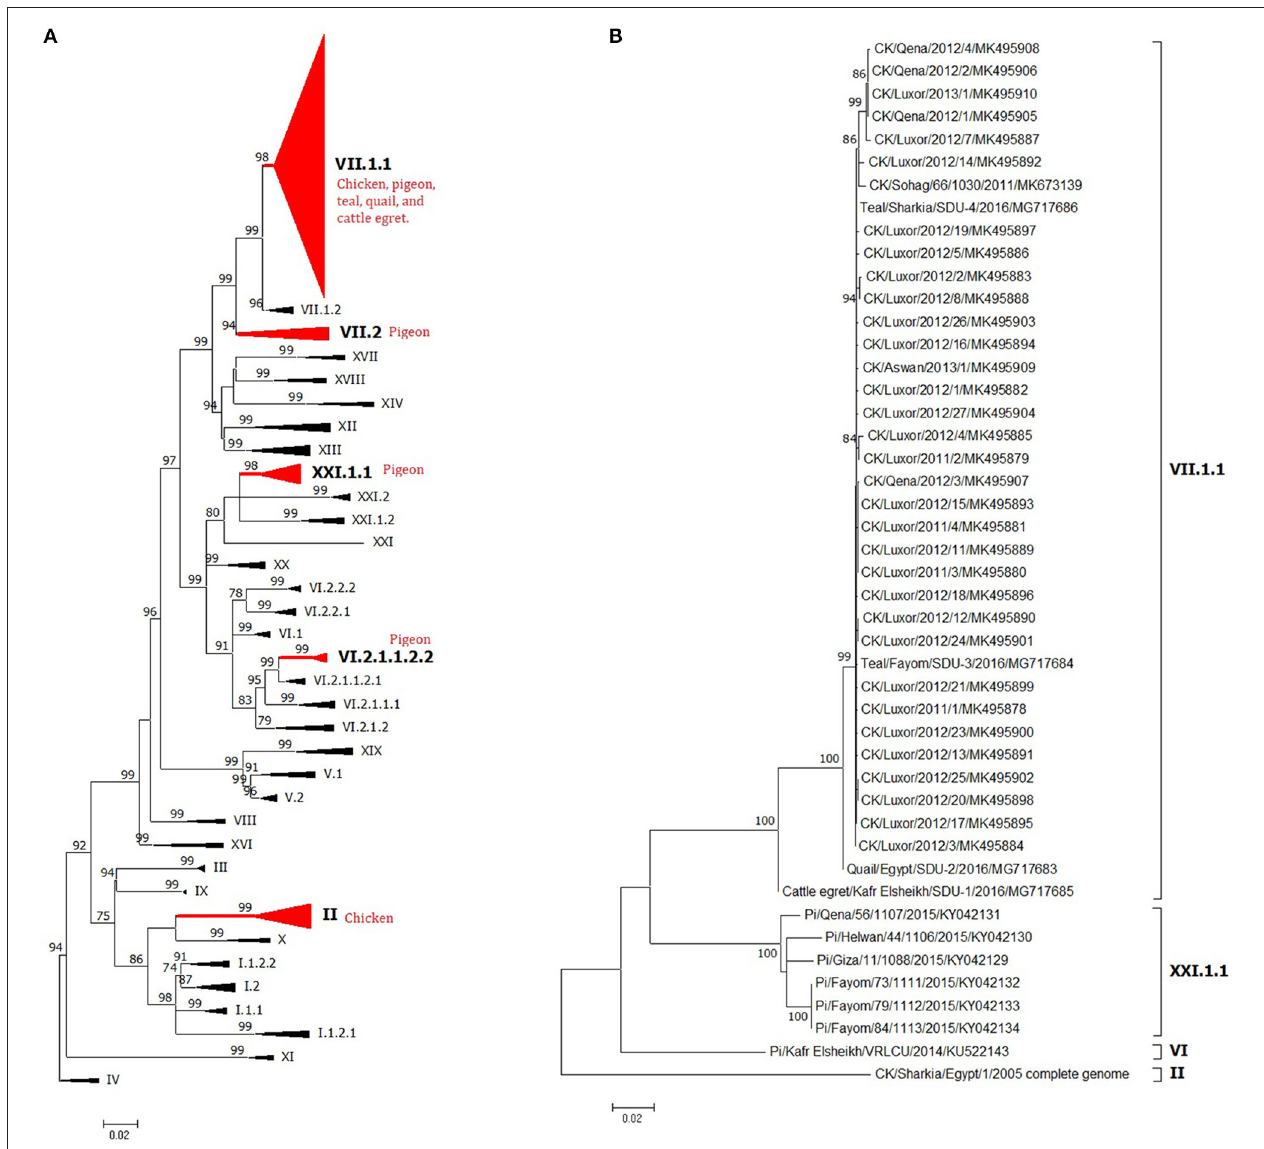
FIGURE 4 | The phylogeny of Egyptian Newcastle disease viruses (NDVs) (A) full F protein gene or (B) full HN protein gene of different Egyptian isolates. The maximum likelihood (ML) tree was built based on the general time-reversible model with a discrete gamma distribution at 1,000 bootstrapping. All genotypes are in Newcastle disease virus (NDV) class II and were assigned with Roman numerals, as suggested by Dimitrov et al. (17). The taxons of F protein gene tree were compressed for better presentation. Sequences from Egypt are labeled with a red